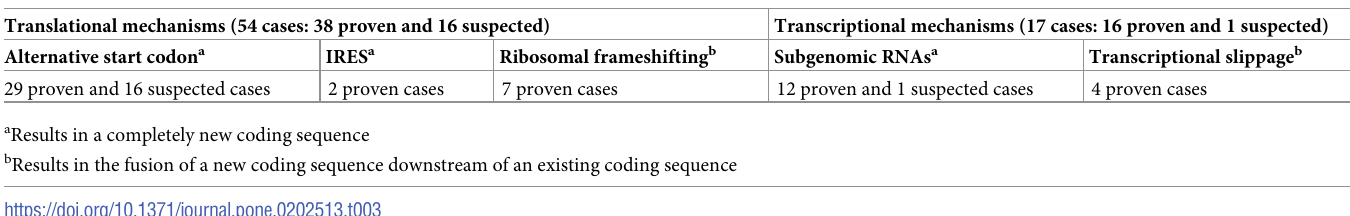
the composition in 1) nucleotides; 2) dinucleotides; 3) amino acids; 4) synonymous codons; and 5) amino acids with high, medium or low codon degeneracy (see Methods). The pooled set of overlapping regions (35,394 nt) differed significantly from that of non-overlapping Table 3. Mechanisms of expression of overlapping